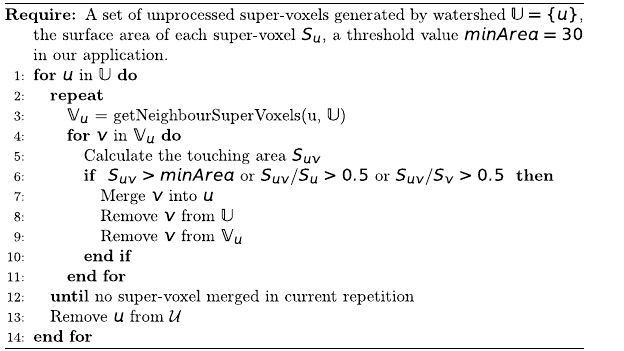
Figure 6. TASCAN algorithm for cell